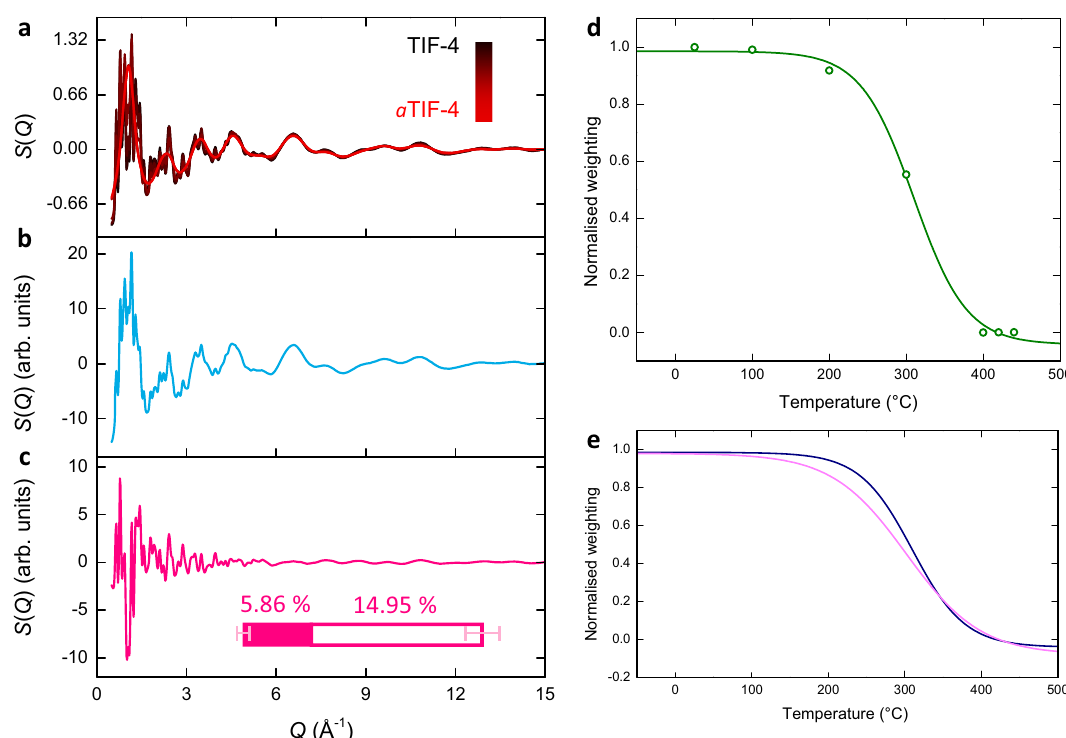
Fig. 9 Reciprocal space. a Experimental in situ structure factors following the melting of TIF-4, and the corresponding ( b ) fi rst and ( c ) second components extracted through PCA. Inset shows a comparison of the relative magnitudes of the variance captured by the distortion component in real ( fi lled) and reciprocal (empty) space, uncertainties represent the variance associated with the discarded principal components. d Temperature-resolved normalised weightings fi tted using a Boltzmann function. e Comparison between the Boltzmann functions obtained for the real and reciprocal space weightings of the distortion.